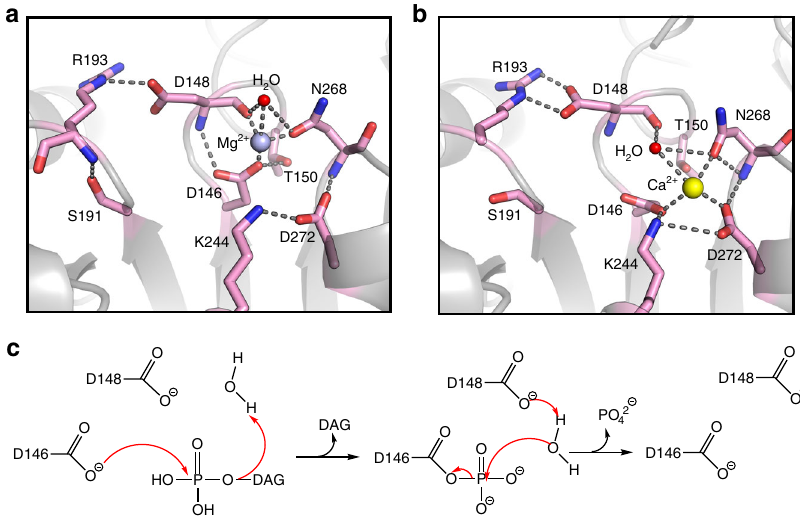
Fig. 3 Active site and catalytic mechanism. a Detailed view of the Tt Pah2 active site with magnesium bound (light blue sphere). Polar contacts are indicated by gray dashes. b Detailed view of the structural rearrangement of key residue interactions in the active site with calcium bound (yellow sphere). c Proposed schematic of lipin/Pah PAPs catalytic mechanism. Catalysis proceeds through a trigonal bipyramidal residues stabilizing the transition state through electrostatic interactions, and Asp148 activating a water molecule for nucleophilic attack to liberate DAG and inorganic phosphate (Fig. 3c).